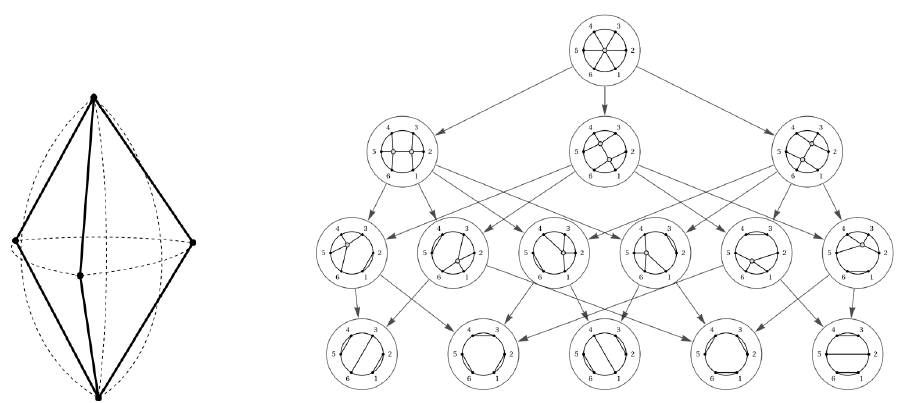
Figure 5 . The orthogonal momentum amplituhedron O 3 and its boundary poset.